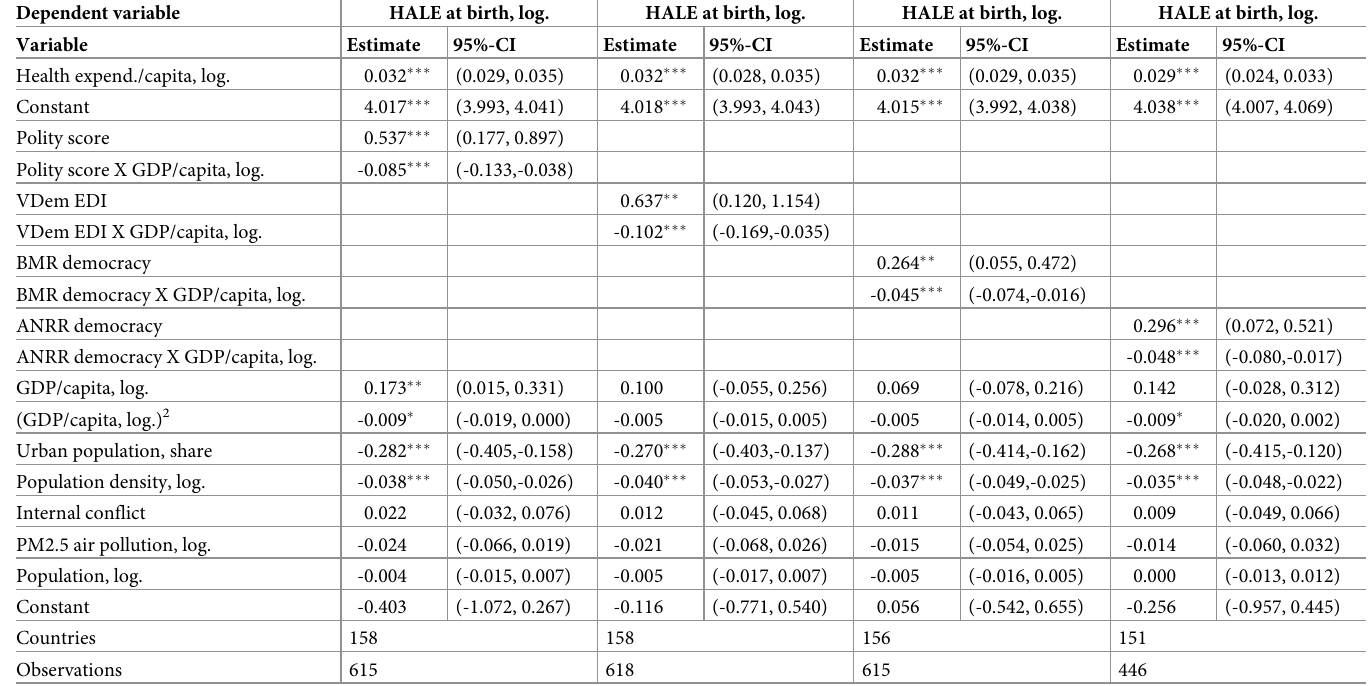
Table 5. SFA results for interactions between democracy and income. Dependent variable HALE at birth, log. HALE at birth,